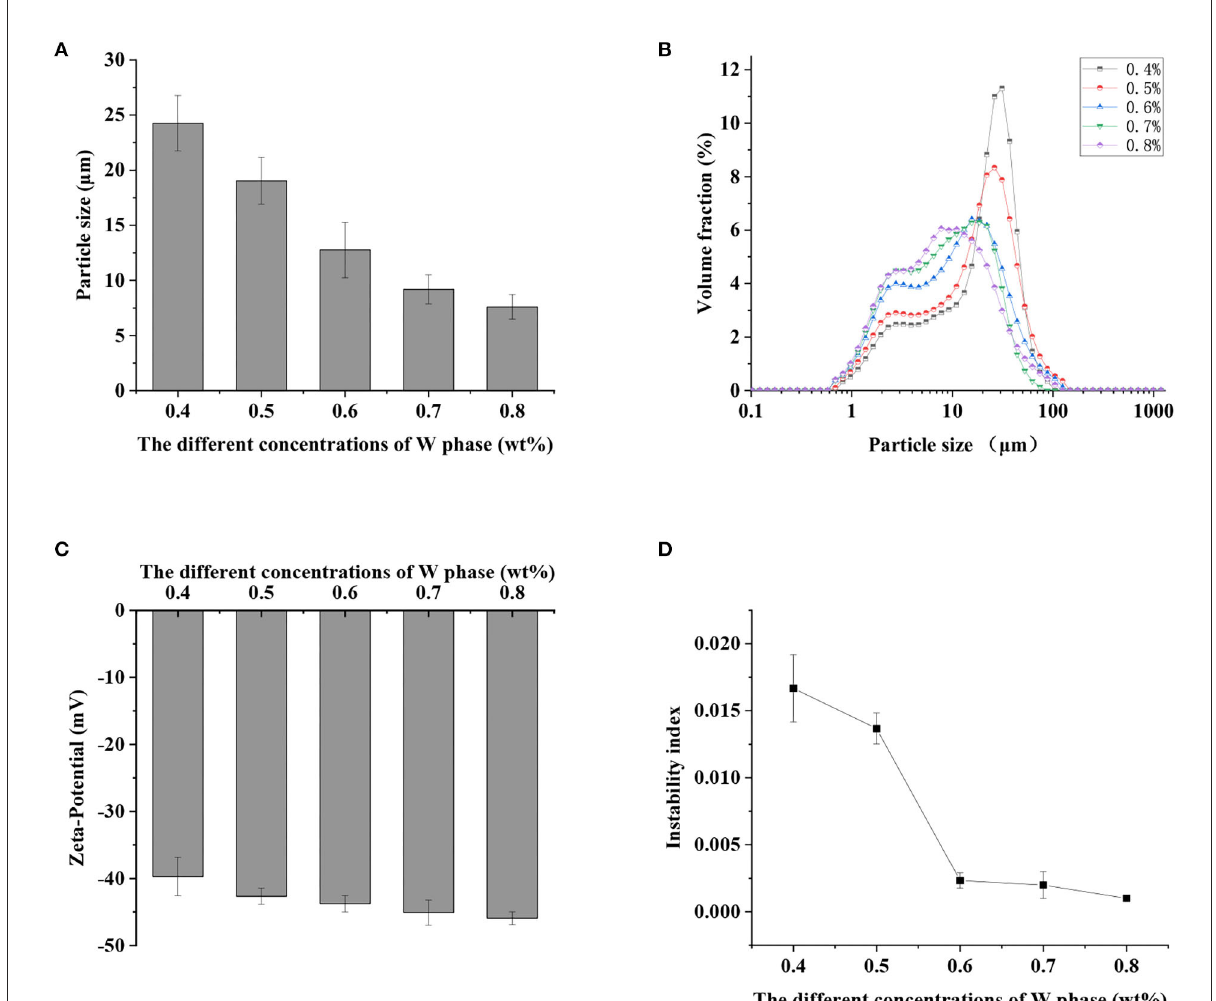
FIGURE1 Effect of the different concentrations of propylene glycol alginate and Xanthan gum (PGA-XG) complexes (0.4, 0.5, 0.6, 0.7, and 0.8 wt%) on the particle size (A) , particle size distribution (B) , zeta potential (C) , and instability index (D) of S/O/W calcium-lipid emulsions.